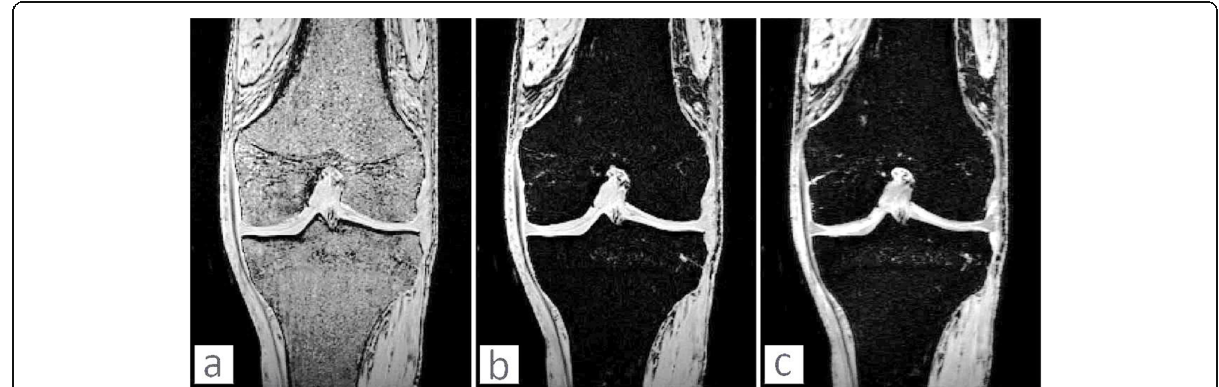
Fig. 1 Acquired MRI sequences: a T1 3D, b T1 3D with fat saturation, c T2